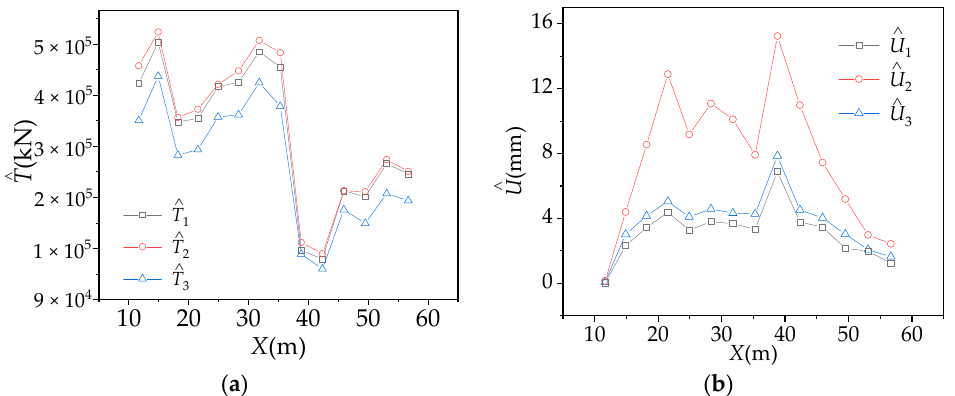
Figure 9. Wind ‐ induced vibration response analysis of cable arrangement throughout cable break ‐ Figure 9. Wind-induced vibration response analysis of cable arrangement throughout cable breakage: age: ( a ) cable tension and ( b ) bridge displacement. ( a ) cable tension and ( b ) bridge displacement.